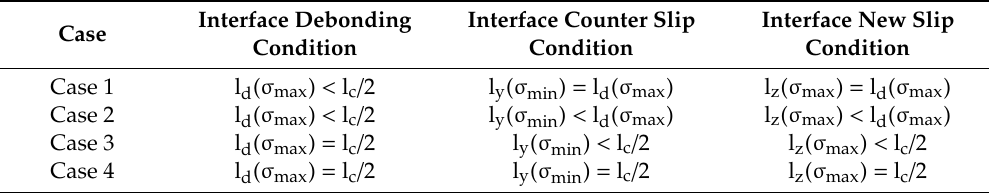
Table 3. Interface debonding and slip state in